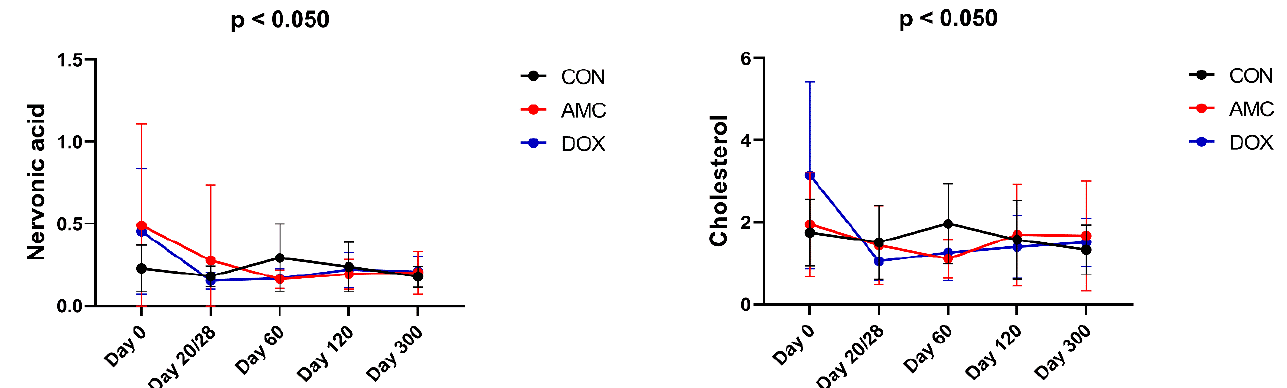
Figure 6. Fecal metabolites that significantly differed among AMC, DOX, and CON cats over the course of the study. Means and standard deviations are displayed. Table 5. Concentrations of fecal metabolites that significantly differed over time within CON